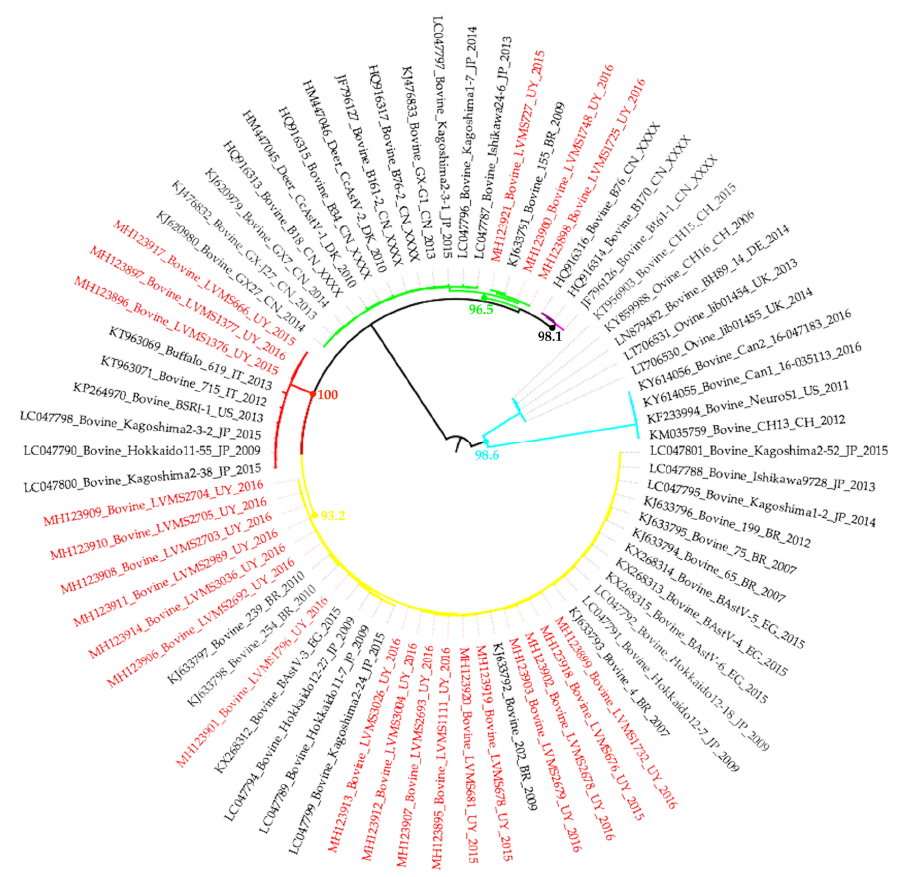
Figure 1. Maximum-likelihood tree constructed with the nucleotide sequences of the partial polymerase genomic region used for BoAstV screening. A 432-nucleotide fragment of the polymerase gene was used for the analysis. TIM2e (AC = AT, CG = GT and equal base frequencies) plus R (FreeRate model, that generalizes the plus Gamma model by relaxing the assumption of Gamma-distributed rates) was used as the nucleotide substitution model that best fitted the data. Branch colors indicate the assigned MAstV species; MAstV-13 (light blue), MAstV-28 (red), MAstV-29 (pink), MAstV-30 (violet), MAstV-33 (green) and MAstV-Unclassified (yellow). Names in red font correspond to Uruguayan strains. Bootstrap values for key nodes are